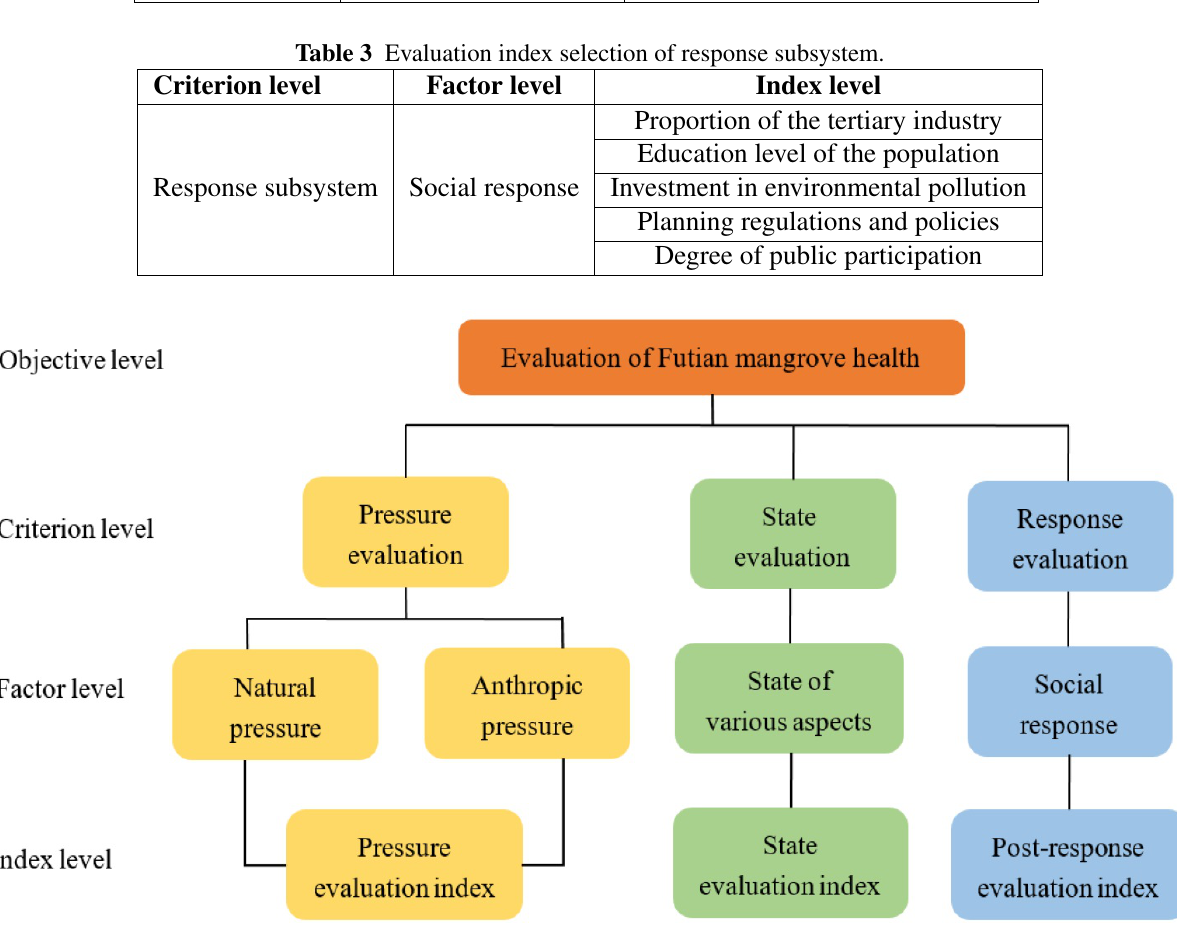
Fig. 3 Evaluation system block diagram based on